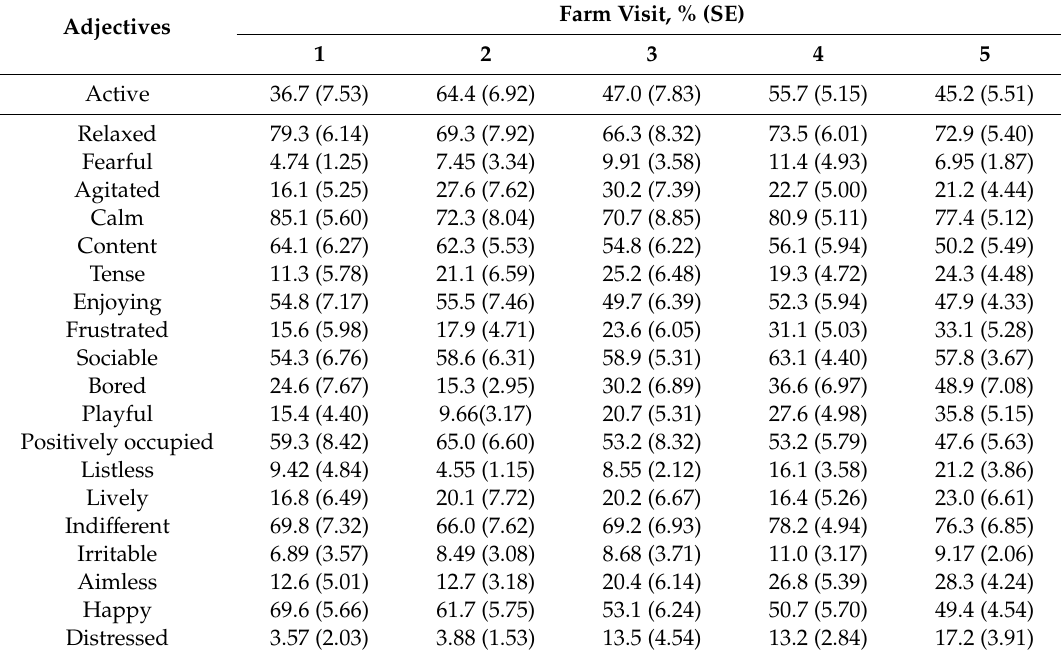
Qualitative Behavior